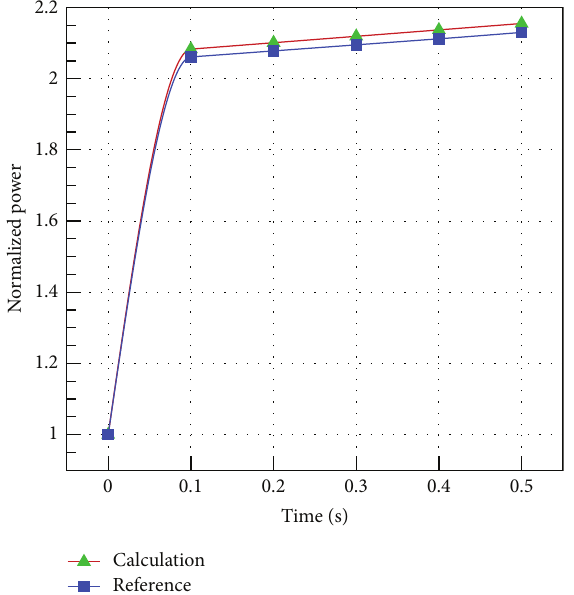
Figure3:NormalizedpowerversustimeinTWIGLproblemduring step perturbation.